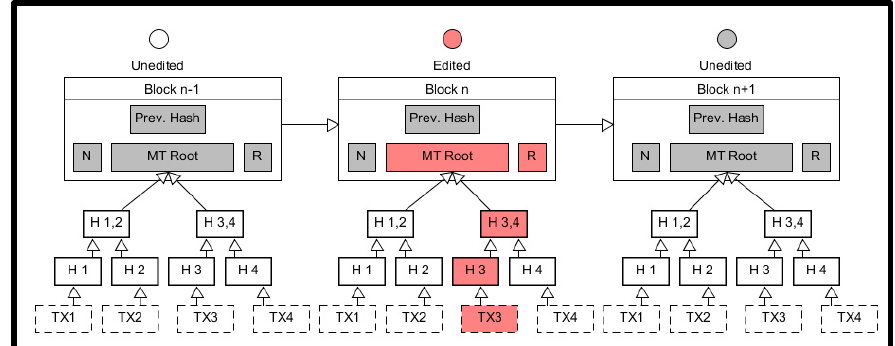
Figure 5. Ateniese’s proposal: randomness update in redacted block (edit).